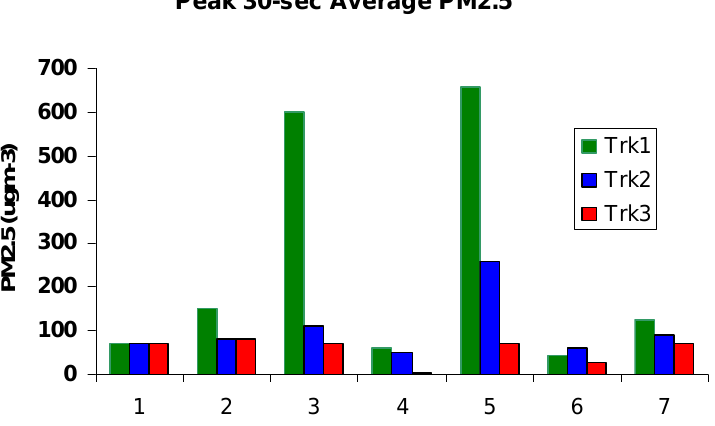
for seven complete data sets from the 2008–2009 Figure 11. Peak 30-s averaged PM 2.5 smoke project at Fort Benning, GA. The burn dates are: ( 1 ) 9 April 2008; ( 2 ) 14 April 2008; ( 3 ) 15 January 2009; ( 4 ) 21 January 2009; ( 5 ) 23 January 2009; ( 6 ) 8 April 2009; and ( 7 ) 9 April 2009. Peak 30-sec Average PM2.5